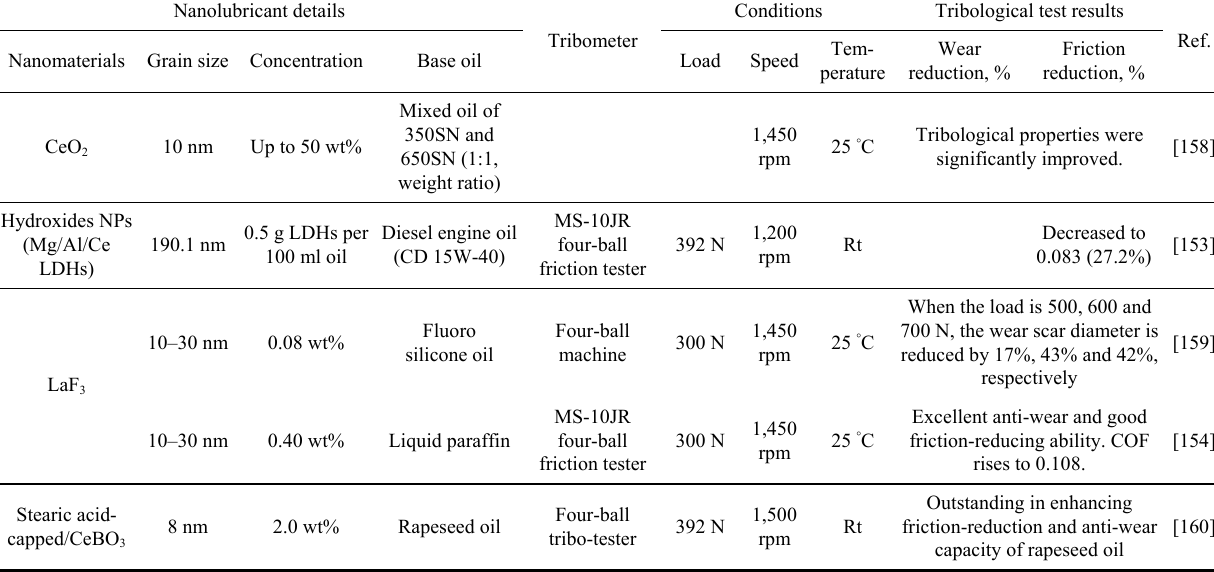
Table 5 Rare-earth compounds as lubricant